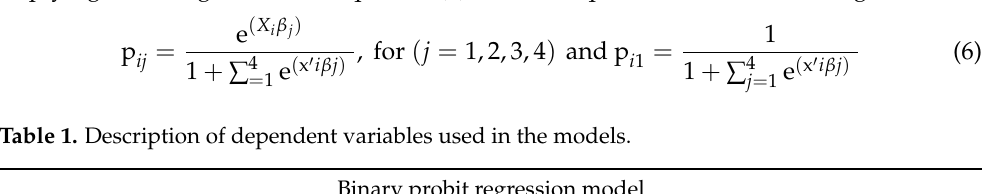
Table 1. Description of dependent variables used in the models. Binary probit regression model y = 1 Diversified from farm work y = 0 Not diversified from farm work Multinomial logistic regression model Choices of livelihood-diversification strategies (J):